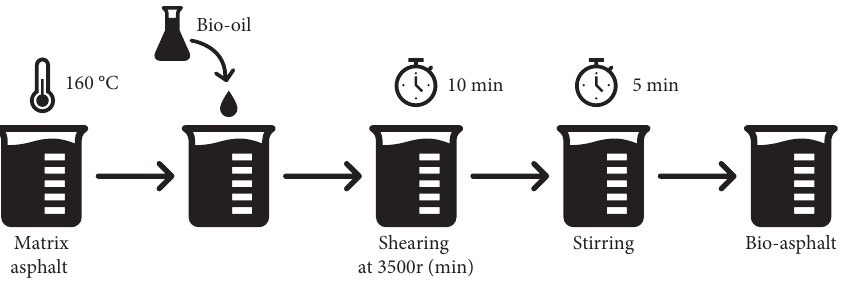
Figure 2: Preparation process of bioasphalt. Table 4: Code abbreviation of test